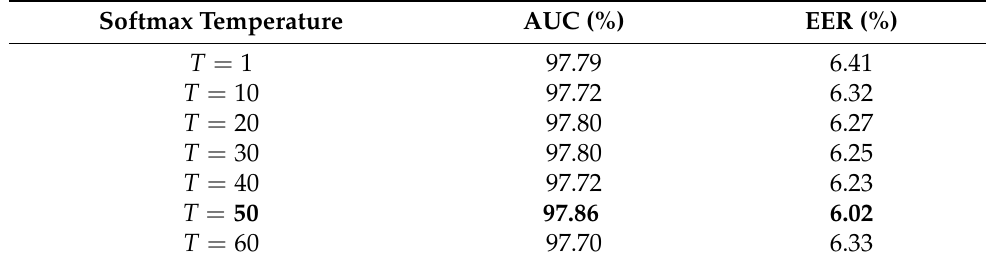
Table 5. AUC (%) and EER (%) on the FS02 development partition using knowledge distillation domain adaptation setup with various softmax temperature values compared to the baseline